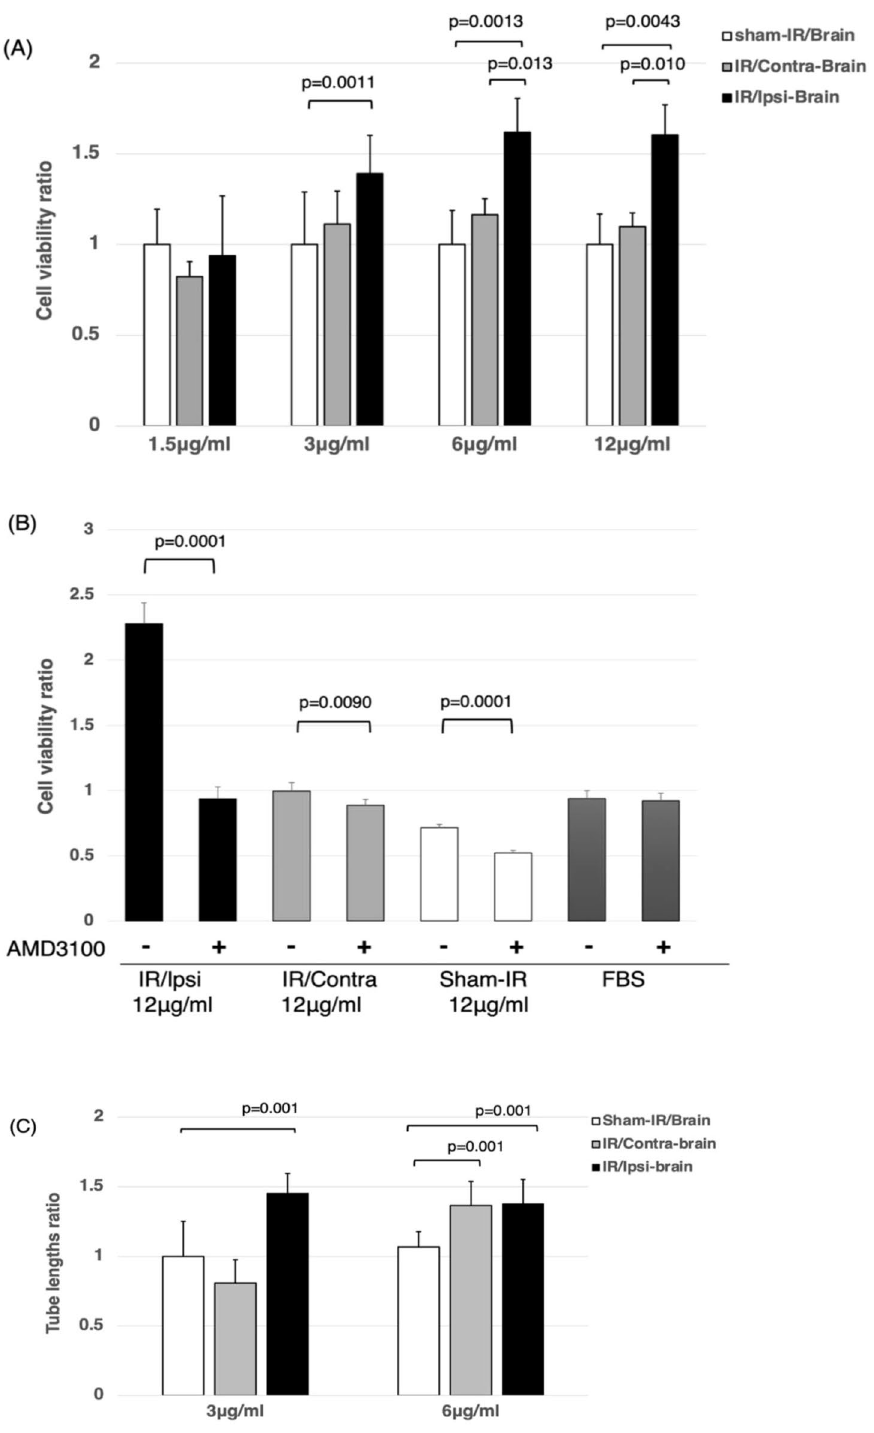
Figure 1. ( A ) The cell-viability ratio under each protein concentration extracted from each group by WST-8 assay. Tissue proteins extracted from the IR/Ipsi-brain group contained significantly higher levels of growth factors compared to the Sham-IR/Brain group under the 3, 6, and 12 μg/ml concentrations of extracted protein. These results were expressed as mean ± SD and comparisons between groups were assessed by Student’s t-test. ( B ) The cell-viability ratio under 12 μg/ml concentrations of extracted protein from each group adding AMD3100(10 μM) by WST-8 assay. The cell-viability ratio adding AMD3100 in IR/Ipsi-brain, IR/Contra-brain, and Sham-IR/Brain groups was significantly inhibited. These results were expressed as mean ± SD and comparisons between groups were assessed by Student’s t-test. ( C ) Measurement of tube lengths by a tube-forming assay under each protein concentration extracted from each group. Tissue proteins extracted from the IR/ Ipsi-brain group contained a significantly higher level of angiogenesis factors compared to those of the Sham-IR/Brain group. Under the protein concentration of 6 μg/ml, significantly longer tube formation was observed in the IR/Contra-brain group compared to the Sham-IR/Brain group. These results were expressed as mean ± SD and comparisons between groups were assessed by Student’s